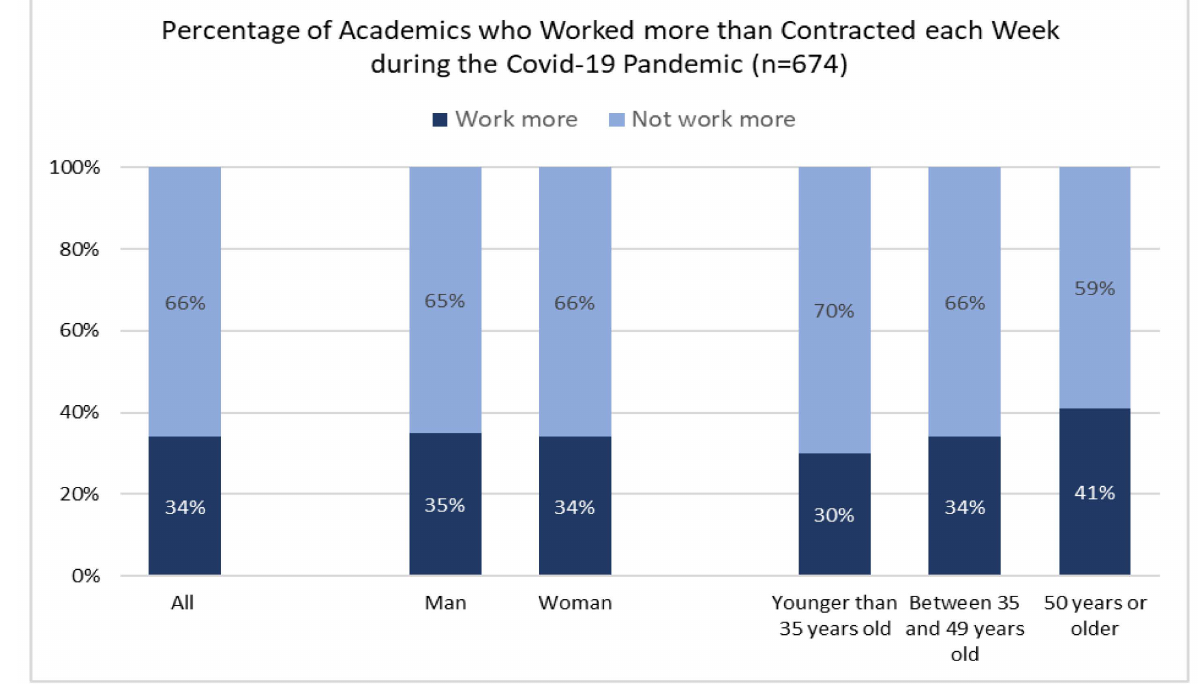
Figure 2. How much academics worked during the COVID-19 pandemic.